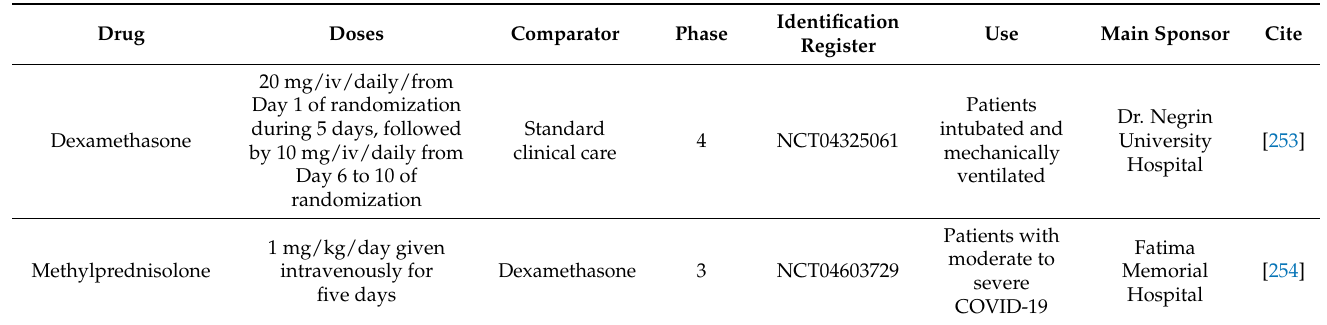
Table 3. Corticosteroids in clinical trials for